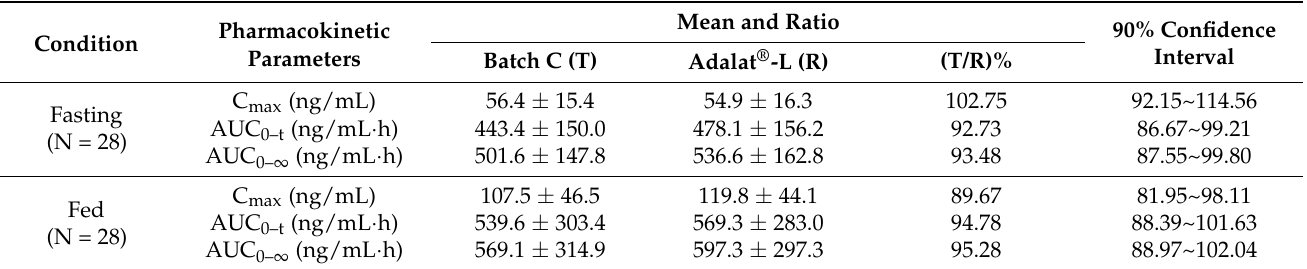
Table 6. Pharmacokinetics parameters analysis of prepared Batch C and Adalat ® -L tablets under fasting and fed